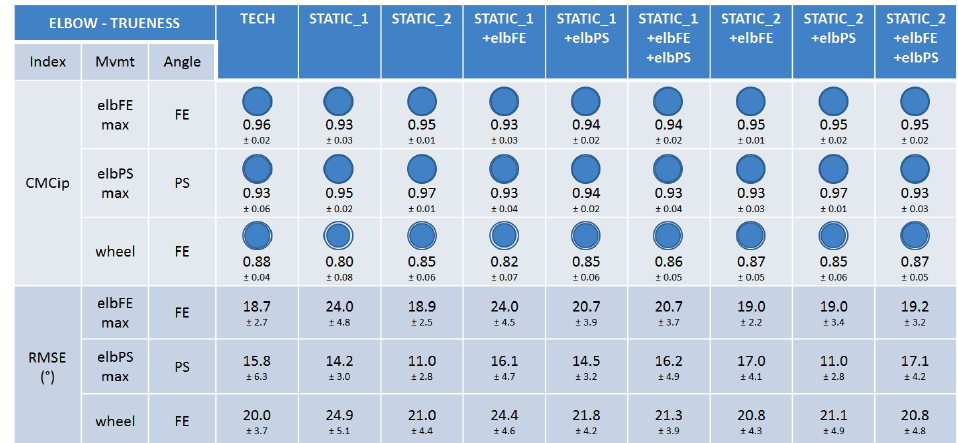
Figure 7. The results on trueness for the elbow joint. CMCip and RMSE values are reported for the different calibrations during the maximal elbow flexion-extension (elbFEmax), maximal forearm pronation-supination (elbPSmax), and wheel movements. For visual clarity, the CMCip value is completed with a proportional blue disc included in a blue circle that represents the optimal value 1.